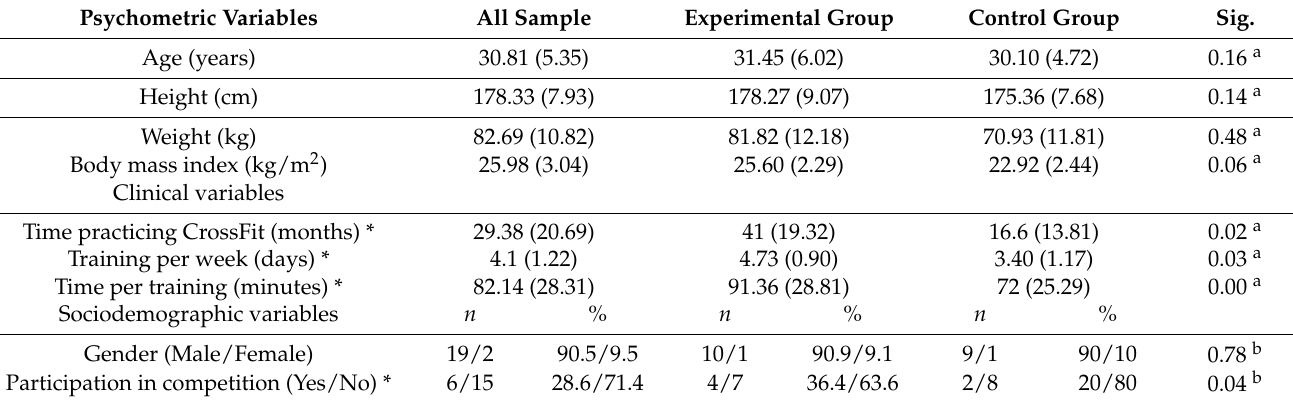
Table 1. Descriptive characteristics of all patients mean (and standard deviation) at baseline and in each group of the study. Psychometric Variables All Sample